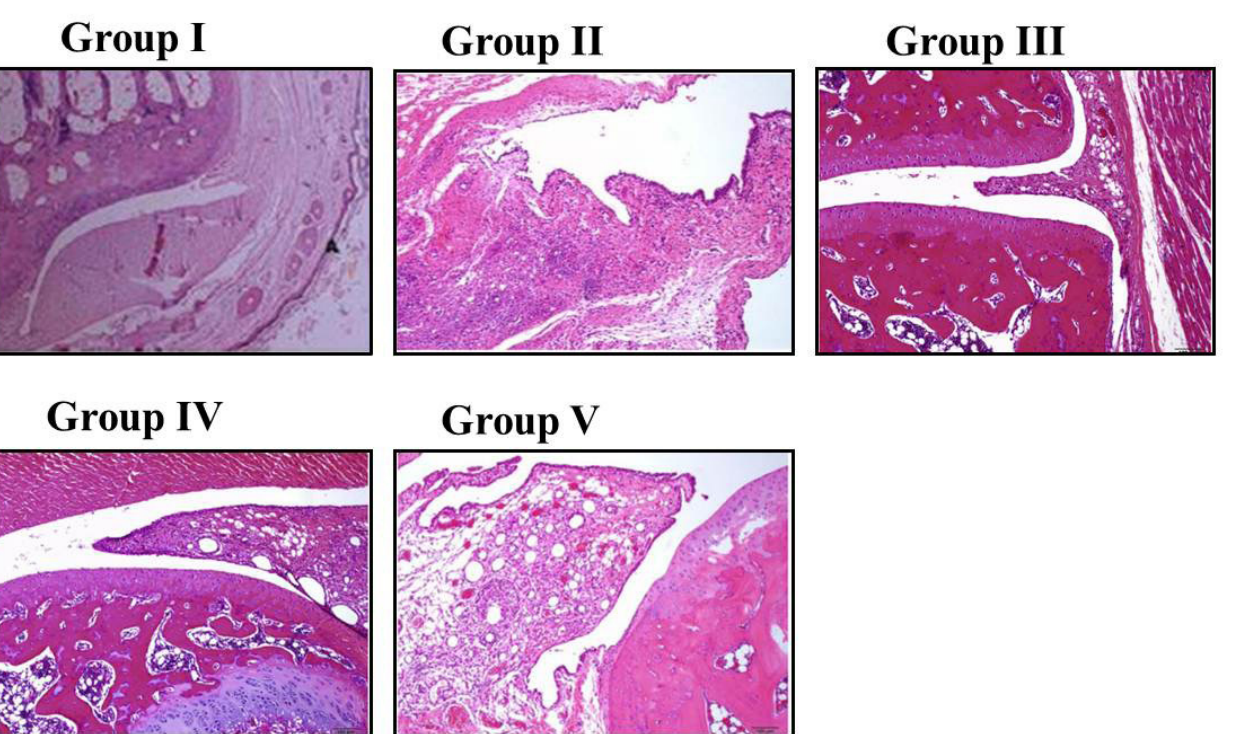
FIGURE 5 - Histopathological alterations by ginkgolic acid on CFA-induced osteoarthritis. Sections of ankle joints from arthritis control Group II shows severe signs of synovial hyperplasia, excessive inflammatory cell infiltrations, abnormal bone cartilage degeneration, and loss of bone marrow. Ginkgolic acid significantly reversed the arthritic condition as demonstrated by Group III and IV. H&E staining at 100×